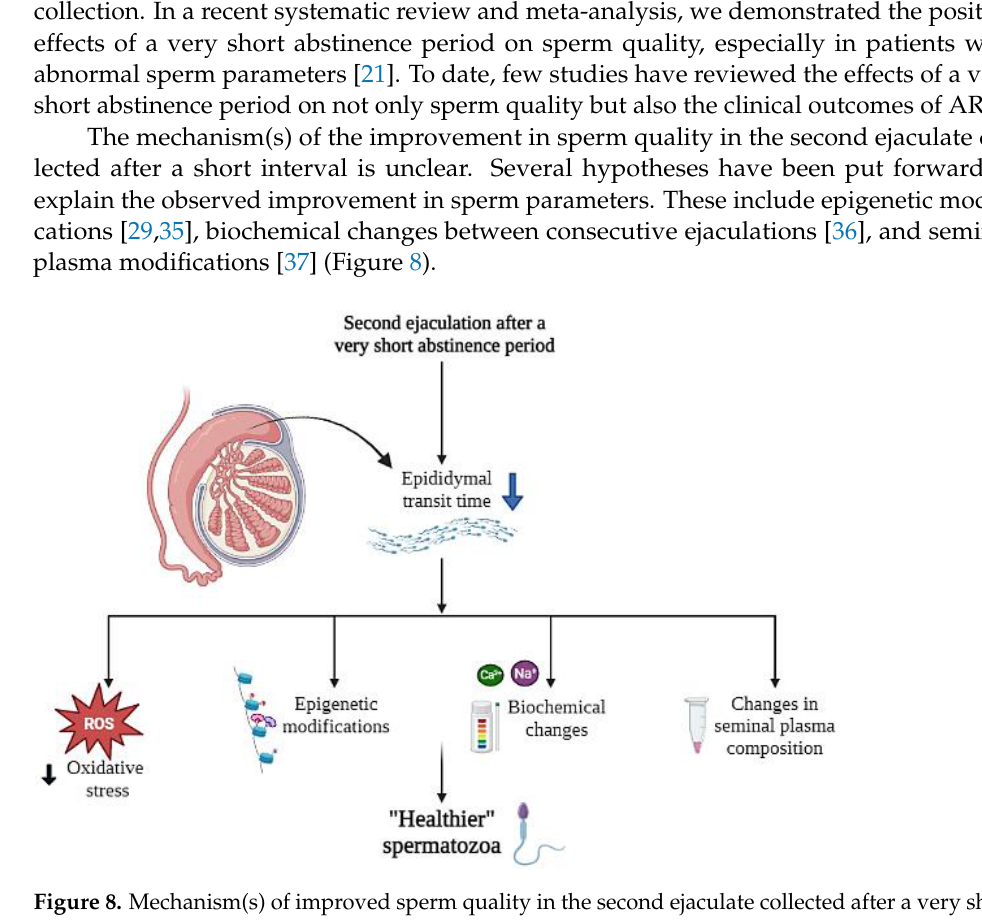
Figure 8. Mechanism(s) of improved sperm quality in the second ejaculate collected after a very short period of abstinence (within 4